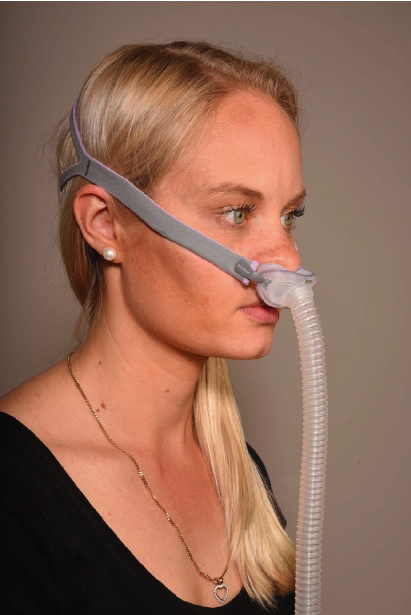
Figure 2: Nasal pillows mask.